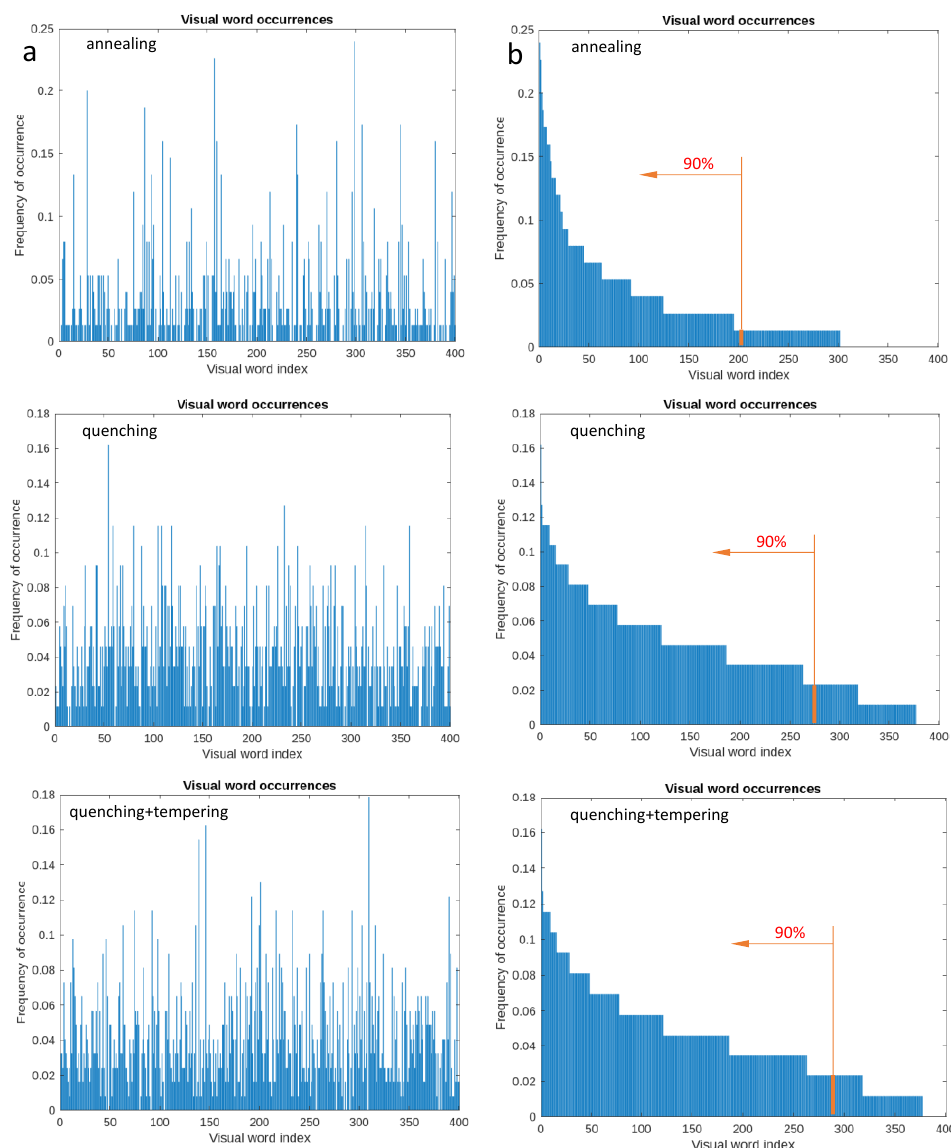
Figure 5. Histograms for visual word occurrence corresponding to the images of the different heat treatments. ( a ) Original histogram representations. ( b ) Histograms sorted from the strongest to the weakest feature.